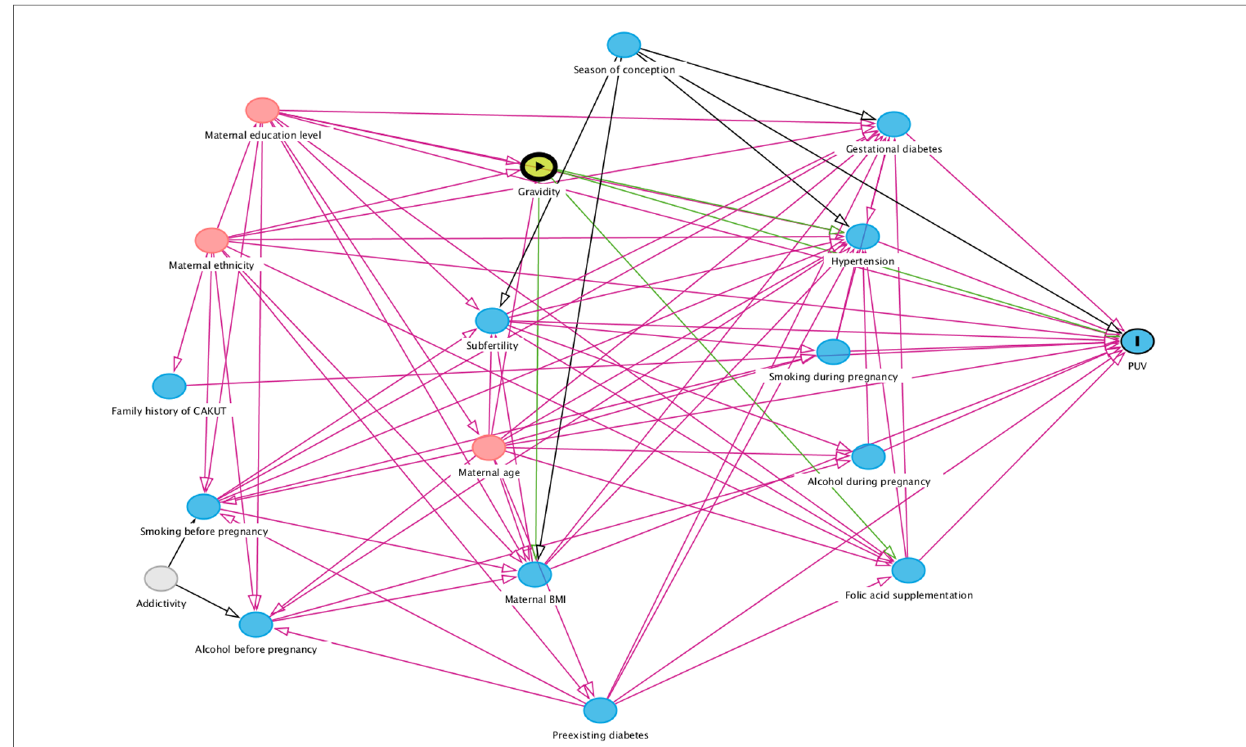
FIGURE 1 Directed acyclic graph containing all potential risk factors and confounders with their causal relations. Blue circles with black lining: outcome. Blue circles: ancestors of outcome. Pink circles: ancestors of exposure and outcome. Yellow circle: exposure. Grey circle: unobserved variable. BMI, body mass index; CAKUT, congenital anomalies of the kidney and urinary tract; PUV, posterior urethral